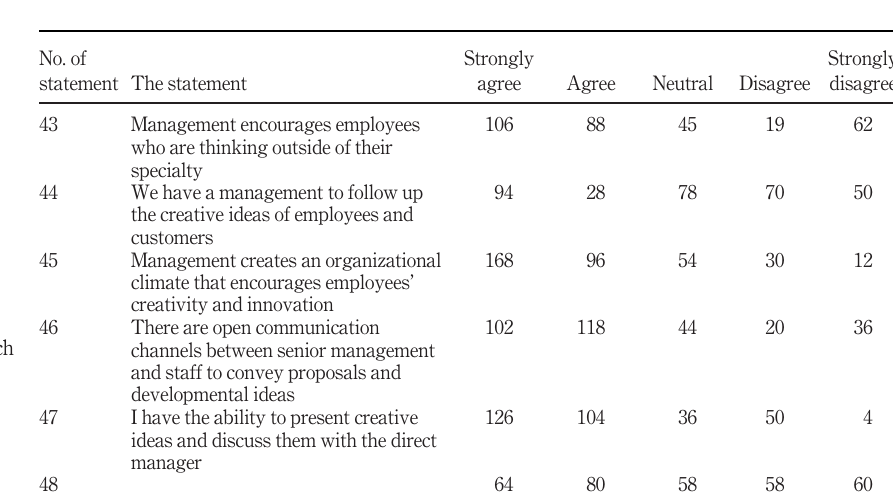
Table A7. Arithmetic mean, standard deviation and probability value (sig.) for the responses to the availability of clients ’